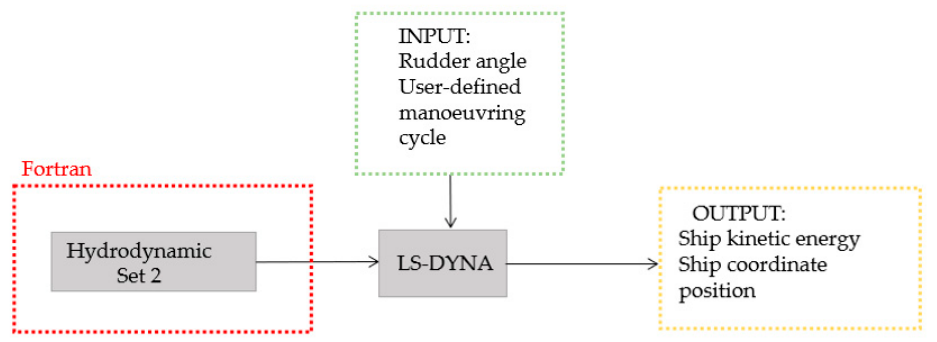
Figure 12. Procedure for rapid analysis of ship collision consequences.